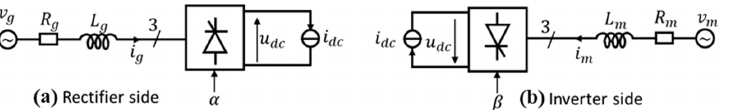
Figure 4. LCI simplified modeling for electromechanical harmonic analysis purpose: ( a ) rectifier side model with its firing angle and line impedance and ( b ) inverter side model with its firing angle and gle and motor impedance. motor